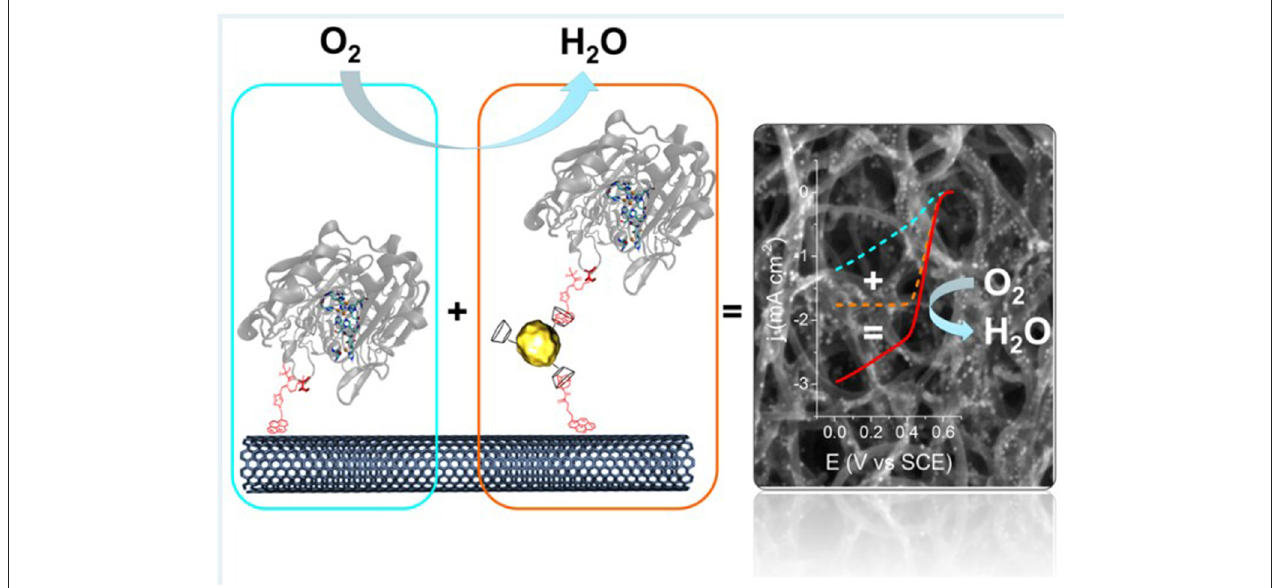
FIGURE 2 | Schematic representing direct bioelectrocatalysis of pyrene-modified laccase immobilized by β -cyclodextrin-modified gold nanoparticles bound to carbon nanotube ( Lalaoui et al., 2016b).